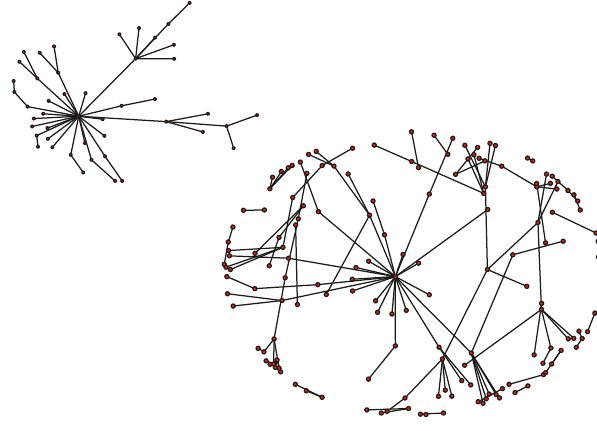
Figure 5: Maximum node attack.